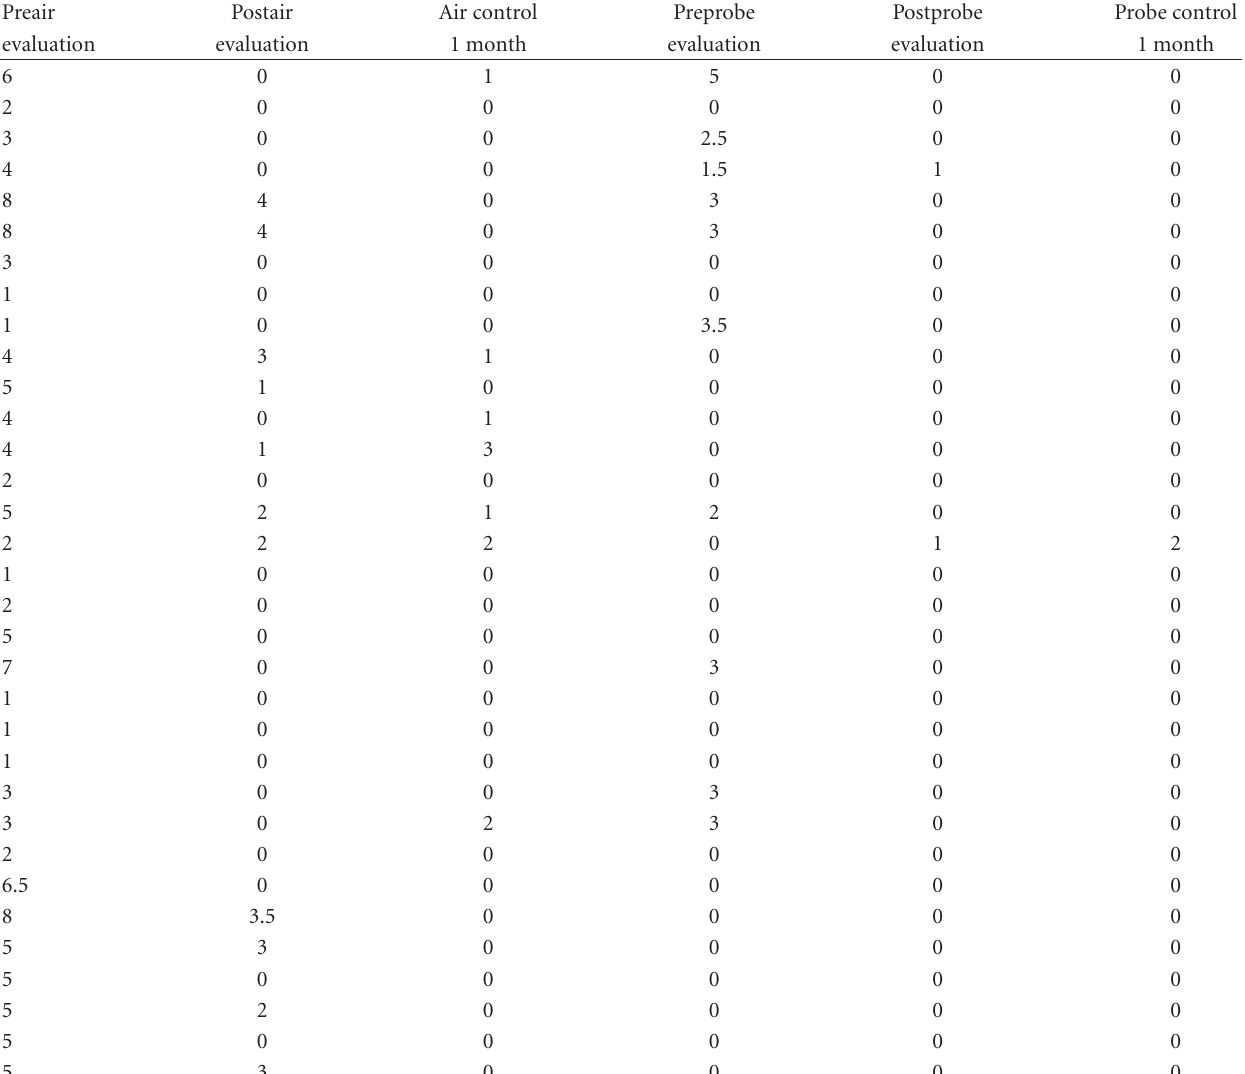
Table 2: Chart of NRS pretreatment, posttreatment, and at 1-month control values of the G2 (only Diode laser). Preair